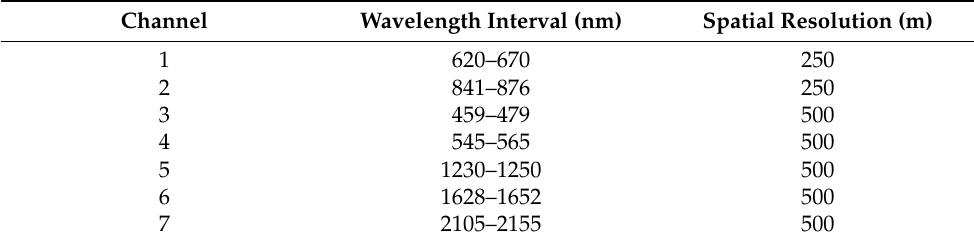
Table 2. Correspondence between block and administrative